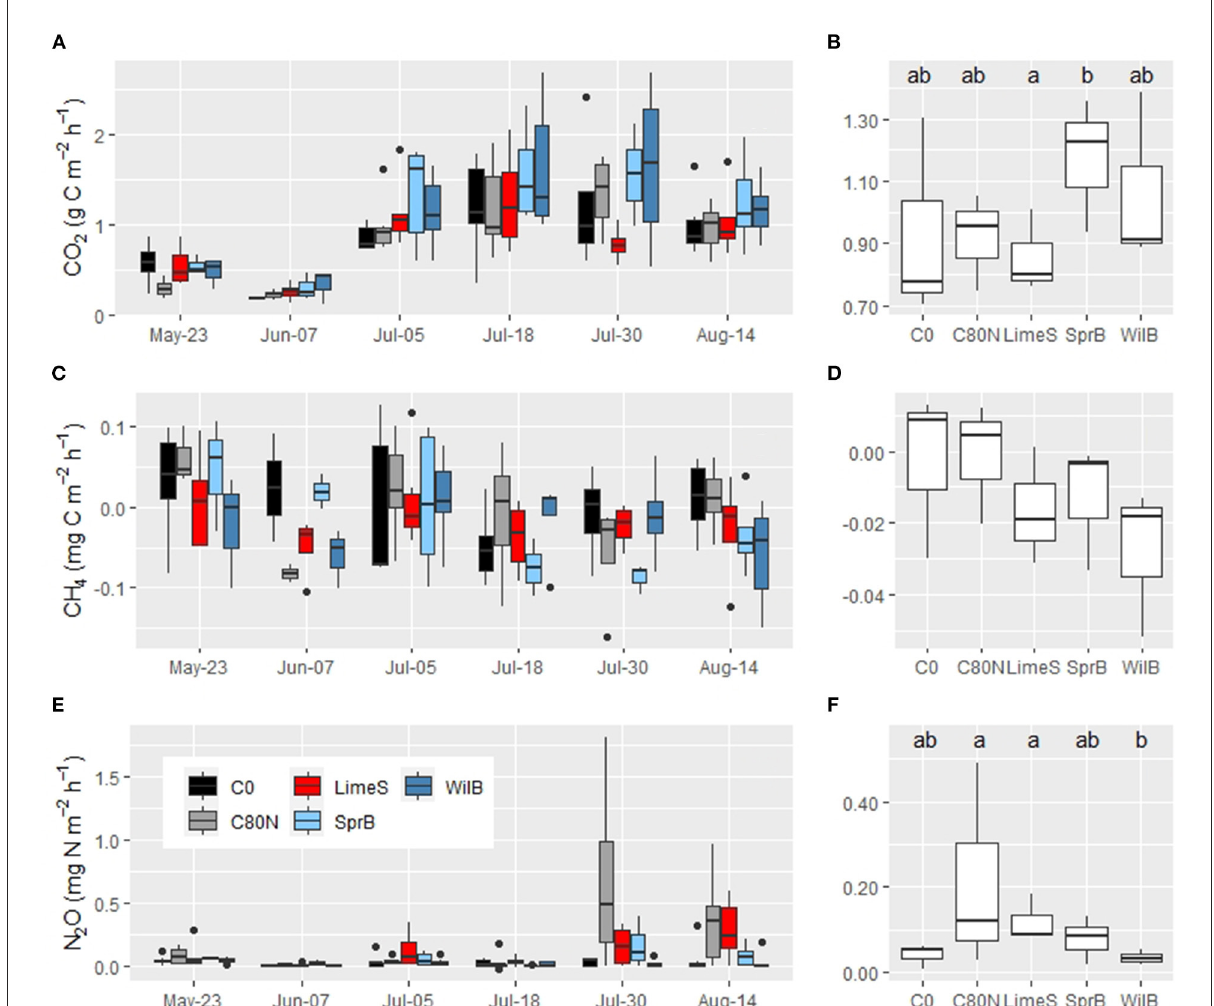
FIGURE8 Left: (A,C,E) Box-and-whisker plots for whole ecosystem flux from vegetated soil in the different treatment plots during each measurement day. Right: (B,D,F) Means of all repetitions. Note the varying y-axis between the left and right panels. C0, non-fertilized control; C80N, fertilized control; LimeS, lime-stabilized pulp sludge; SprB, spruce biochar; WilB, willow